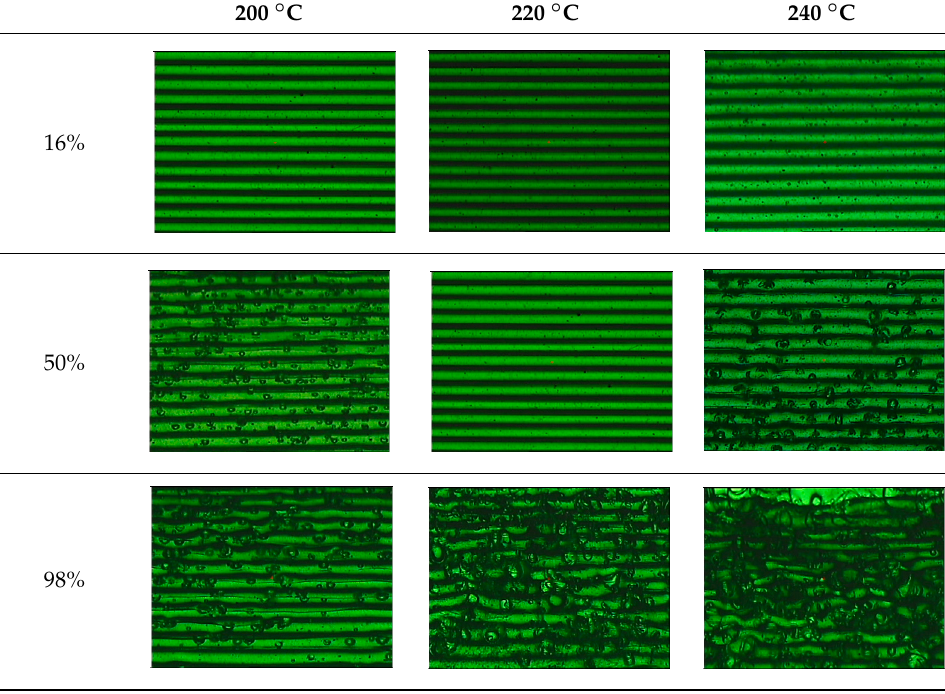
Table 3. Influence of storage conditions and operating temperature on the surface finish.